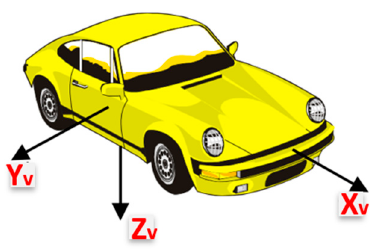
Figure 3. Vehicle frame (Body frame).